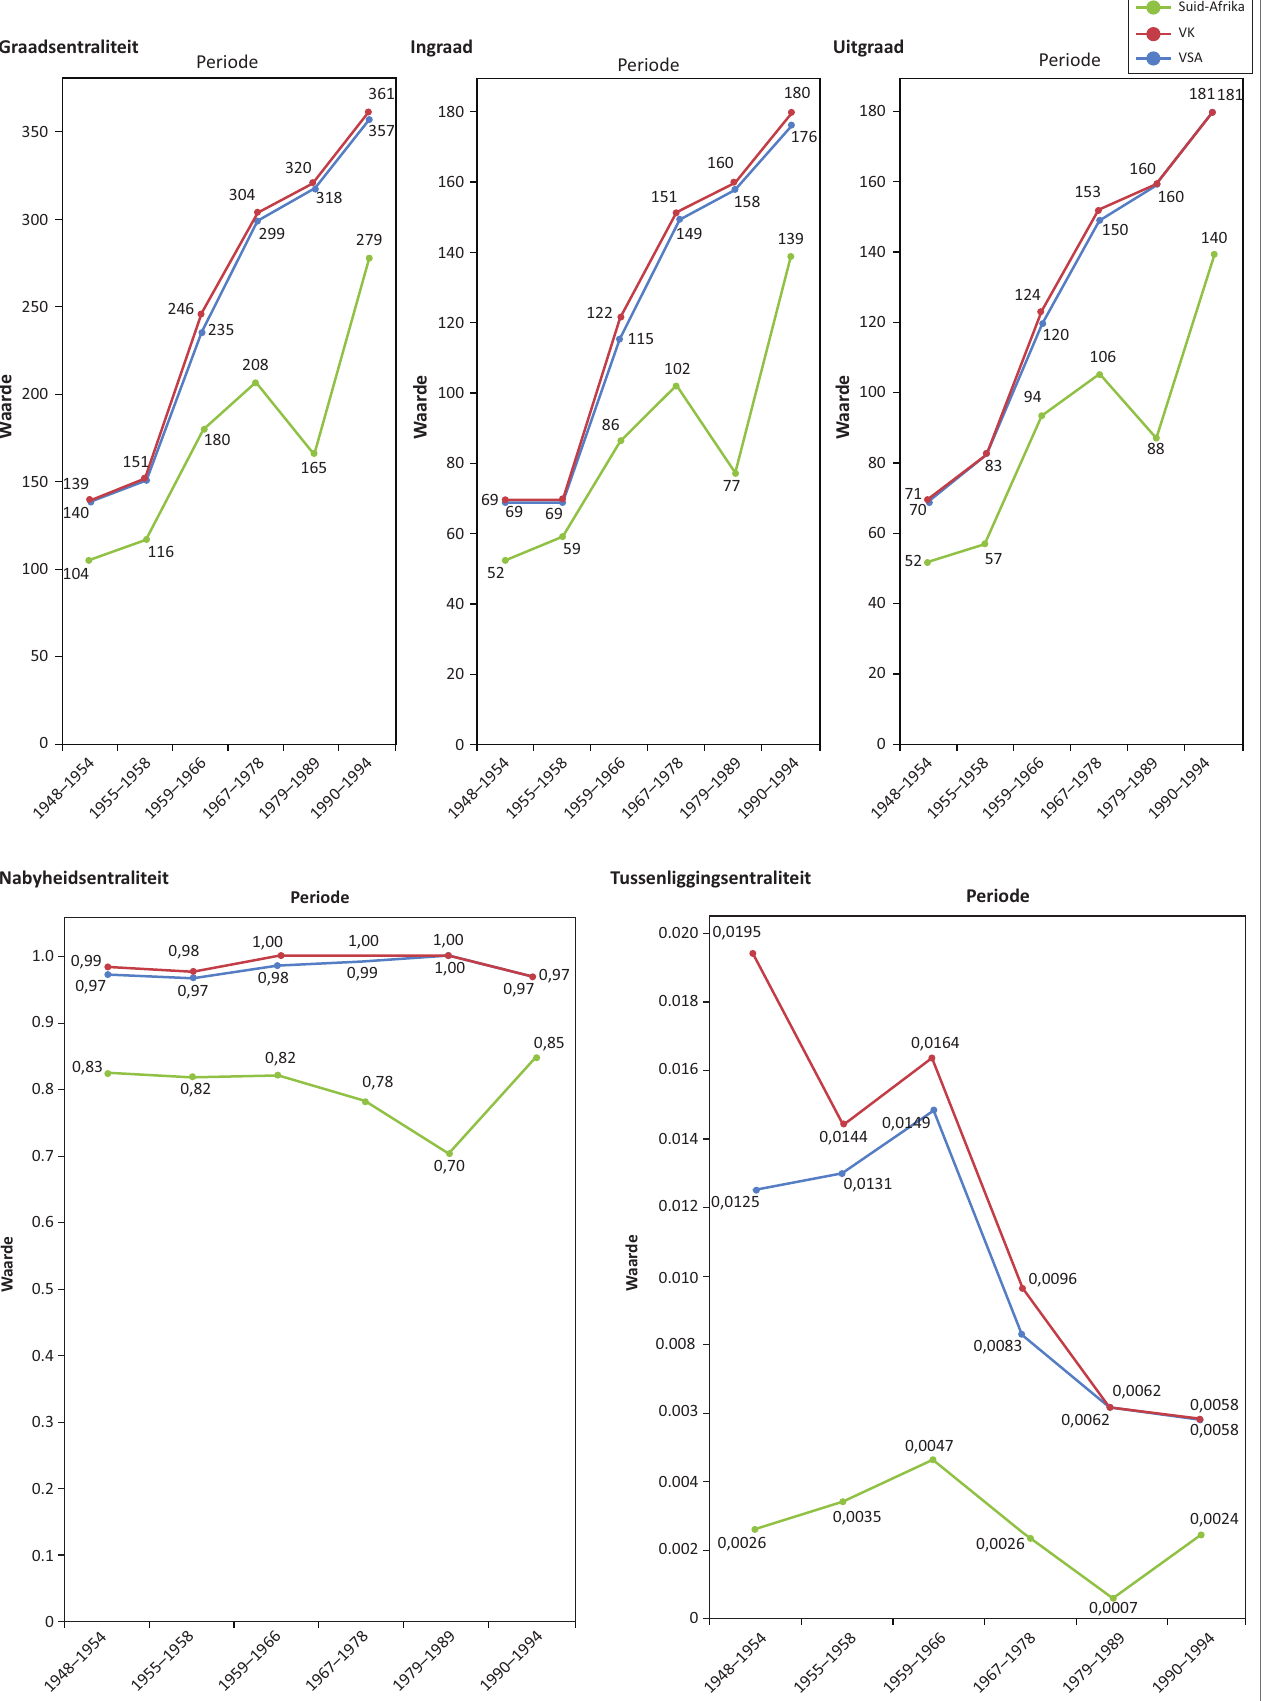
Figuur 2: Sentraliteit van Suid-Afrika, die VSA en VK in die